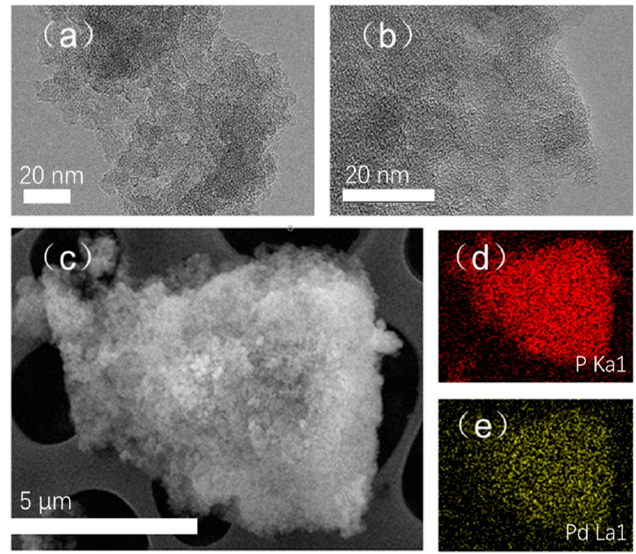
Catalysts 2021 , 11 , x FOR PEER REVIEW Figure 2. TEM images of ( a ) fresh and ( b ) used Pd@POPs, ( c ) SEM images of used Pd@POPs, SEM mapping images of used Pd@POPs, ( d ) P with red color, and ( e ) Pd with yellow color.